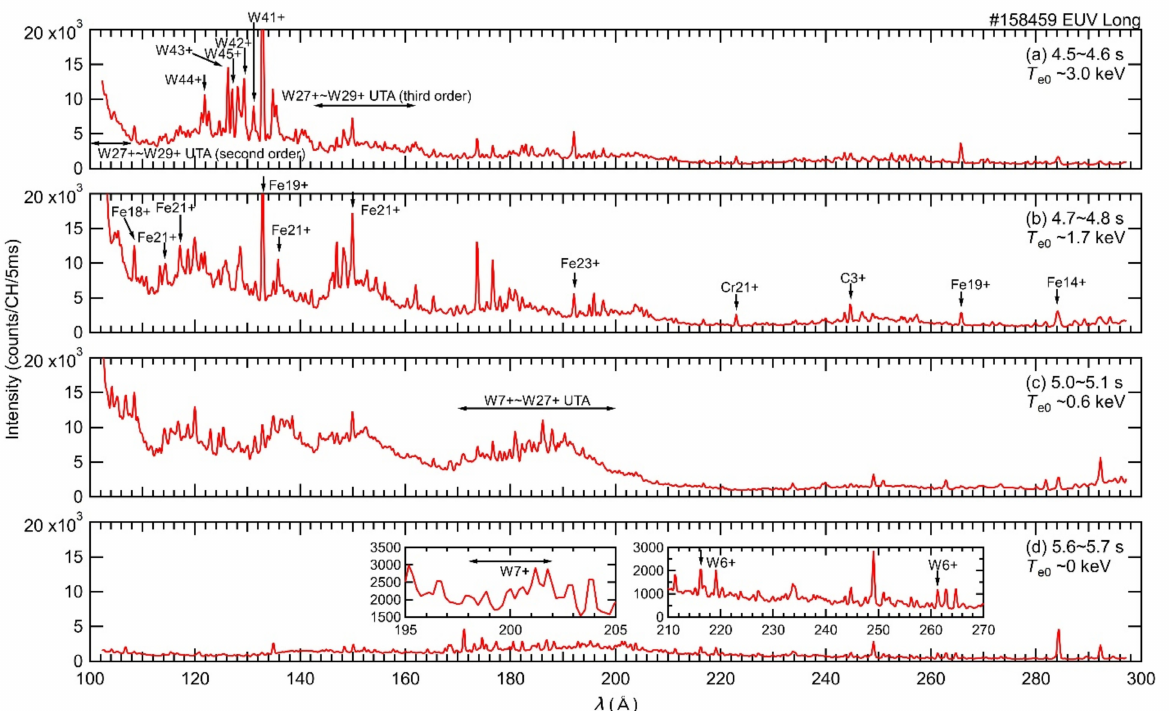
Figure 6. EUV spectra including W 6+ , W 7+ , and W 41+ –W 45+ line emissions in the wavelength range of 100–300 Å measured using “EUV Long” spectrometer with T e 0 for each timing of data acquisition. ( a ) 4.5~4.6 s, T e 0 ~3.0 keV, ( b ) 4.7~4.8 s, T e 0 ~1.7 keV, ( c ) 5.0~5.1 s, T e 0 ~0.6 keV, ( d ) 5.6~5.7 s, T e 0 ~0